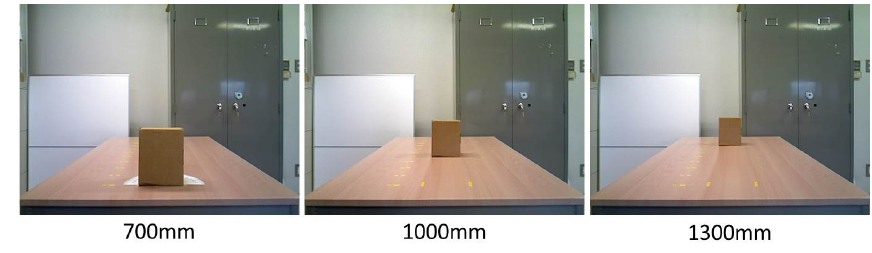
Figure 7: Three situations for fundamental experiments